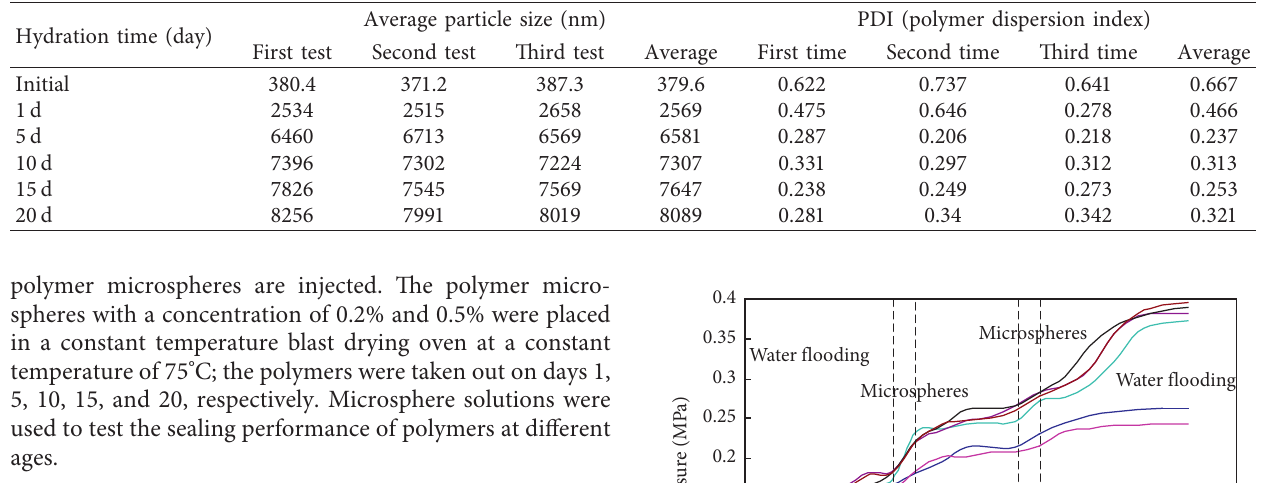
Table 1: Average particle sizes of the polymeric microspheres.